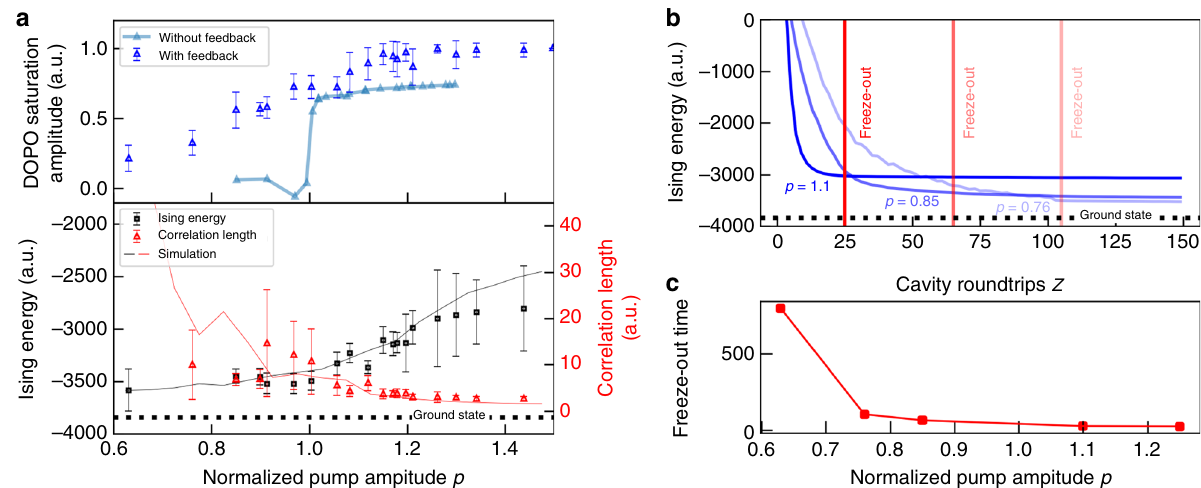
Fig. 3 Effect of dynamical freeze-out on calculation performance in the regular 2D lattice. a Saturation amplitude (blue and teal triangles), Ising energy (black squares) and correlation length (red triangles) for the regular 2D lattice after 1000 cavity roundtrips. The solid lines are obtained from numerical simulations. Error bars represent the standard deviation of 50 trials. b Time evolution of the Ising energy during the ground state search for pump amplitudes p = {1.1, 0.85, 0.76}. Estimated freeze-out times are represented by red lines. c Scaling of the freeze-out time with pump amplitude